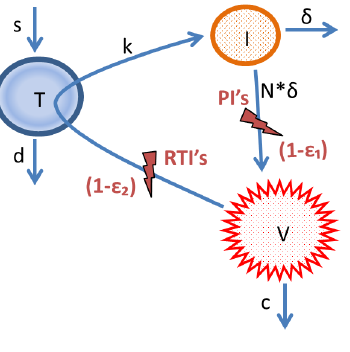
Fig. 2. Model of viral infection under PI and RTI